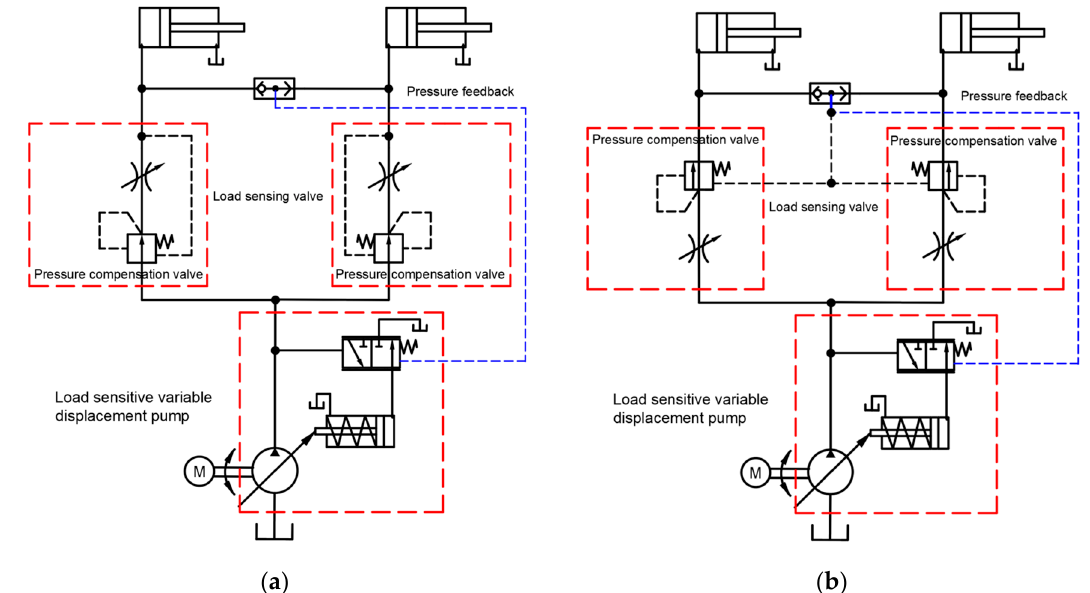
Figure 6. Schematic diagram of compensated hydraulic synchronous control system. ( a ) Schematic diagram of pre-valve compensation hydraulic synchronization control system; ( b ) Schematic diagram of post-valve compensation hydraulic synchronization control system.